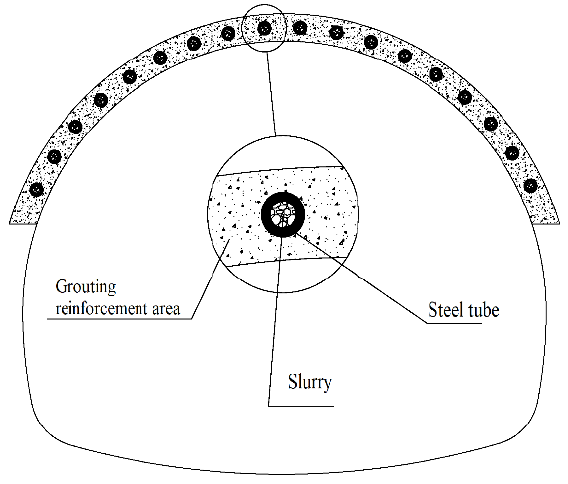
Figure 1. Schematic diagram of the bearing members of a pipe roof.